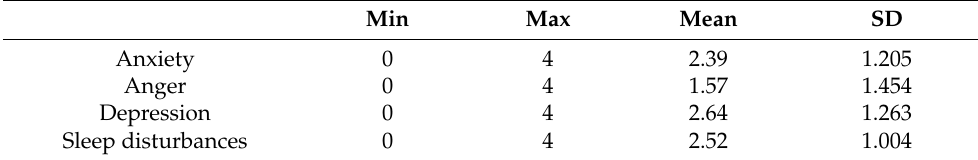
Table 4. Refugees’ mean and standard deviations of mental health